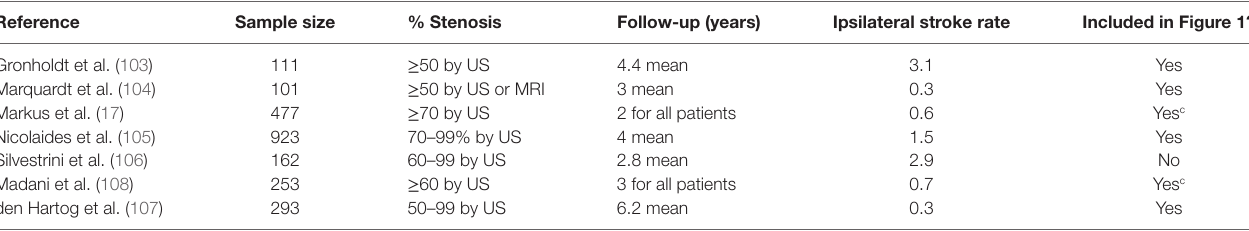
taBLe 1 | Average Annual Ipsilateral “Stroke” Rates in studies considered for the 2013 updated meta-analysis of patients with moderate–severe ( ≥ 50%) asymptomatic carotid stenosis given medical treatment alone. a,b